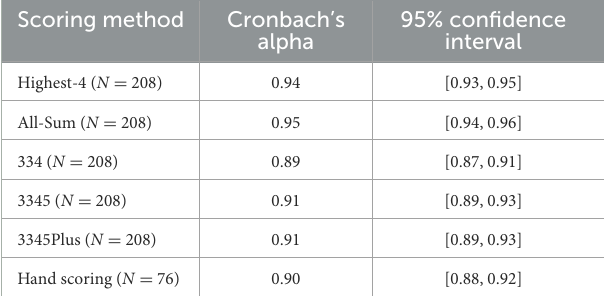
TABLE 4 Internal consistency of scoring methods using Cronbach’s